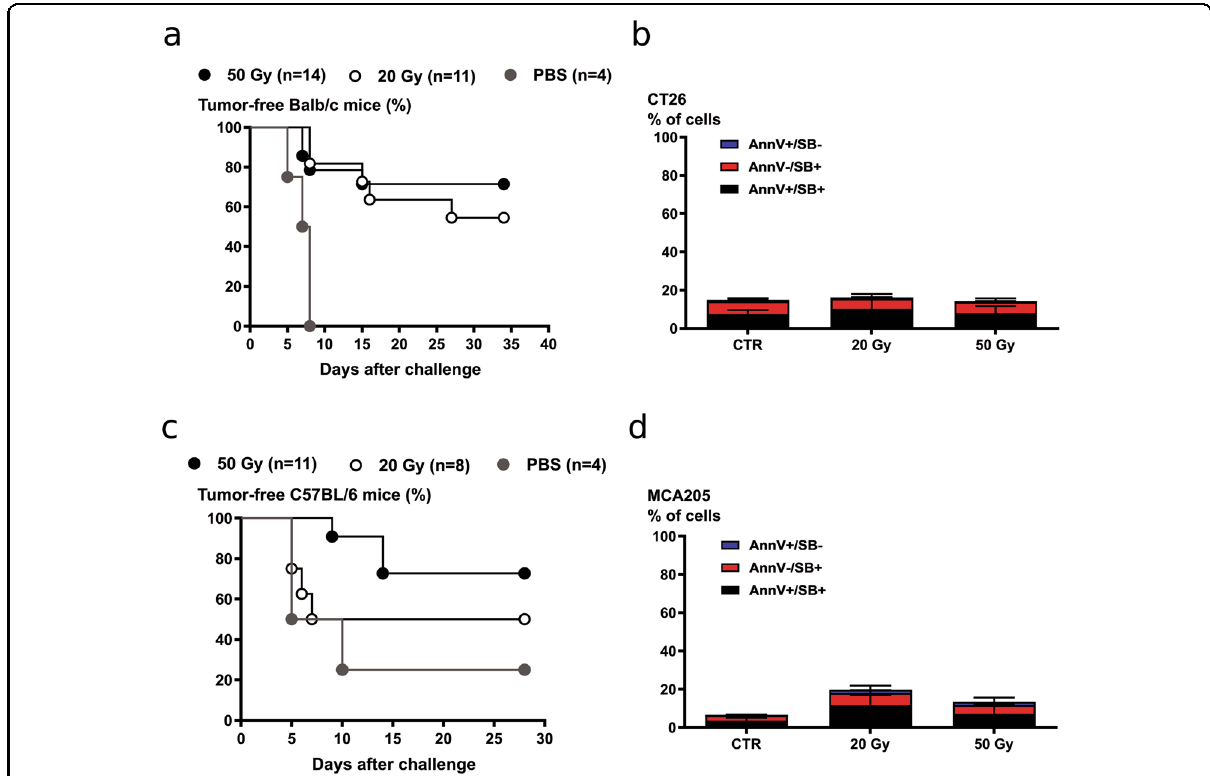
Fig. 1 Prophylactic vaccination with high-dose irradiated cells (20 or 50 Gy) induce immune protection in mice. CT26 and MCA205 cells were irradiated with 20 or 50 Gy the day before the vaccination. PBS or cells irradiated with 20 and 50 Gy were injected subcutaneously in Balb/c. After 7 days, the mice were injected on the opposite fl ank with living cells. Tumor growth was monitored every 2 days up to 35 days post-challenge. Percentage of tumor-free mice after vaccination with irradiated CT26 cells and MCA205 cells are shown in a and c , respectively. The extent of cell death measured as Annexin V positivity (AnnV), Sytox Blue (SB) positivity, and a combination of the two was minimal at the time of injection and is shown in b (CT26 cells) and in d (MCA205